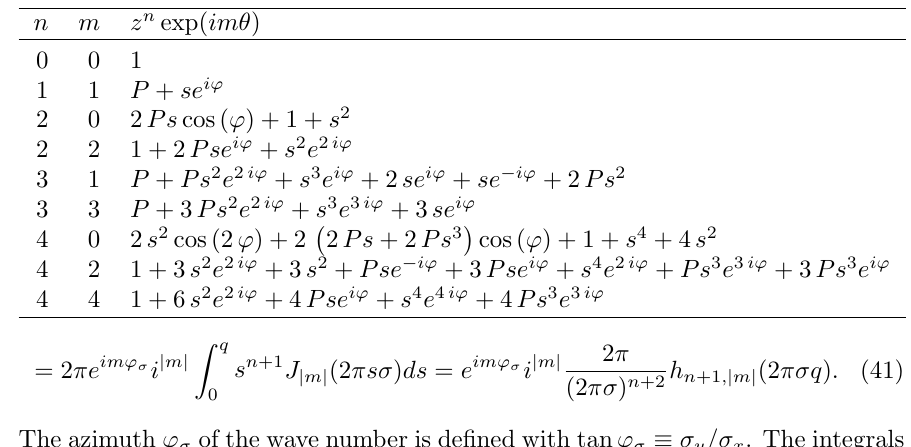
Table 2. Examples of the primitive basis function in the integral (38) translated to ( s, φ ) coordinates. The cases of negative m follow immediately by complex-